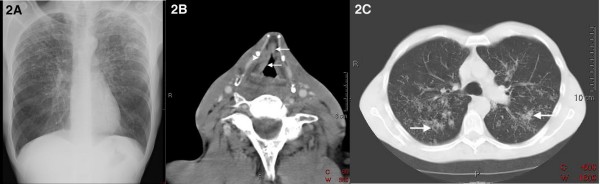
Radiography. (A) Initial antero-posterior chest X-ray. Miliary nodules predominantly bilaterally distributed in the upper parts of the lung parenchyma. (B) Axial contrast-enhanced computed tomography image of the neck: enhanced mass (arrows) in the false vocal cord which extends into the anterior commissure and obliteration of the paraglottic fat (arrowhead). (C) Axial high resolution computed tomography image of the chest: diffusely distributed interstitial nodular alterations with formation of central cavities (arrows).